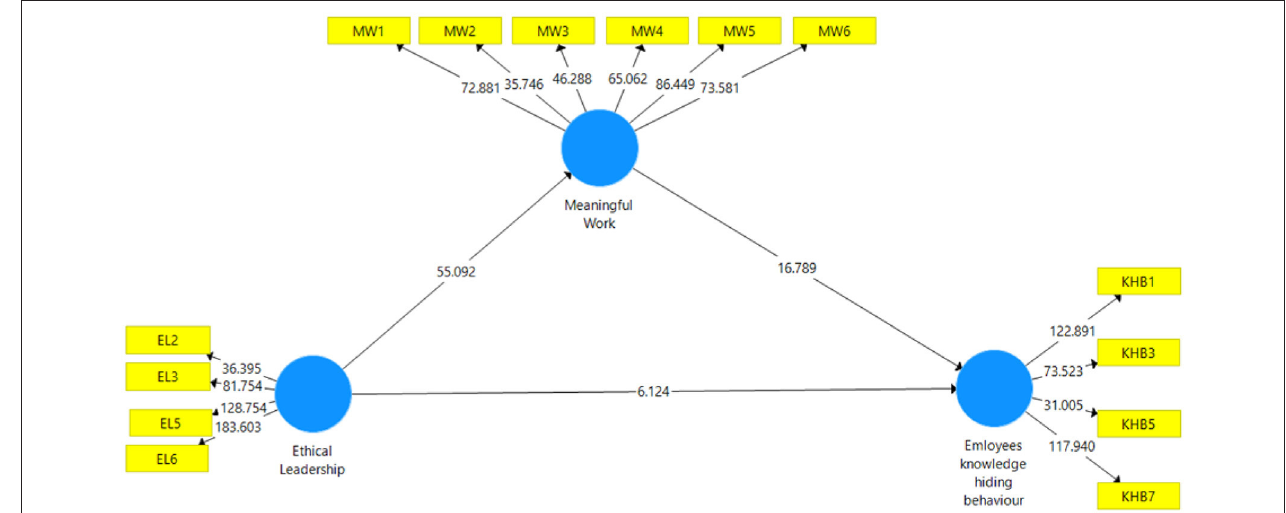
FIGURE 3 | Structural model.